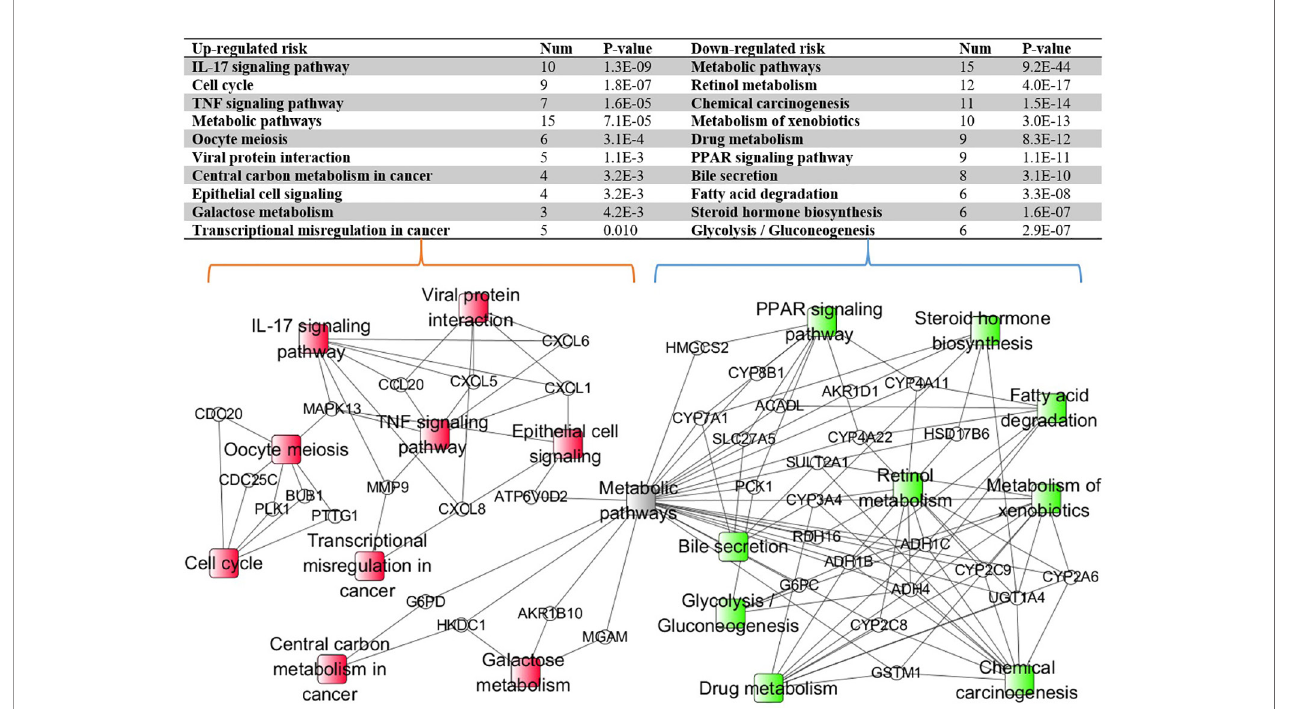
FIGURE 6 | The Kyoto Encyclopedia of Genes and Genomes (KEGG) pathway – gene network enriched by using the connected differentially expressed genes (DEGs). The ellipse nodes represent the genes and the rectangle nodes represent the enriched KEGG pathways. Red represents the upregulated risk path, green represents the downregulated risk group, and gray represents the path simultaneously enriched by different risk group